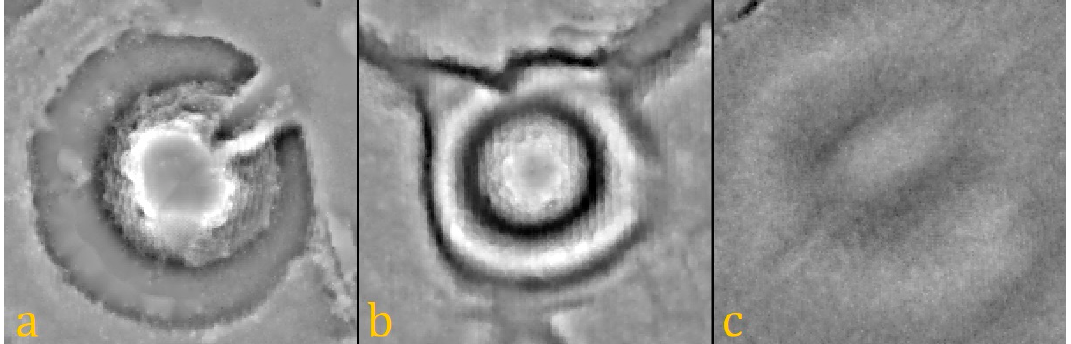
Figure 3. Overview of the different castles from the reference data: ( a ) Borken, ( b ) Paderborn, and ( c ) Warburg [13,16].